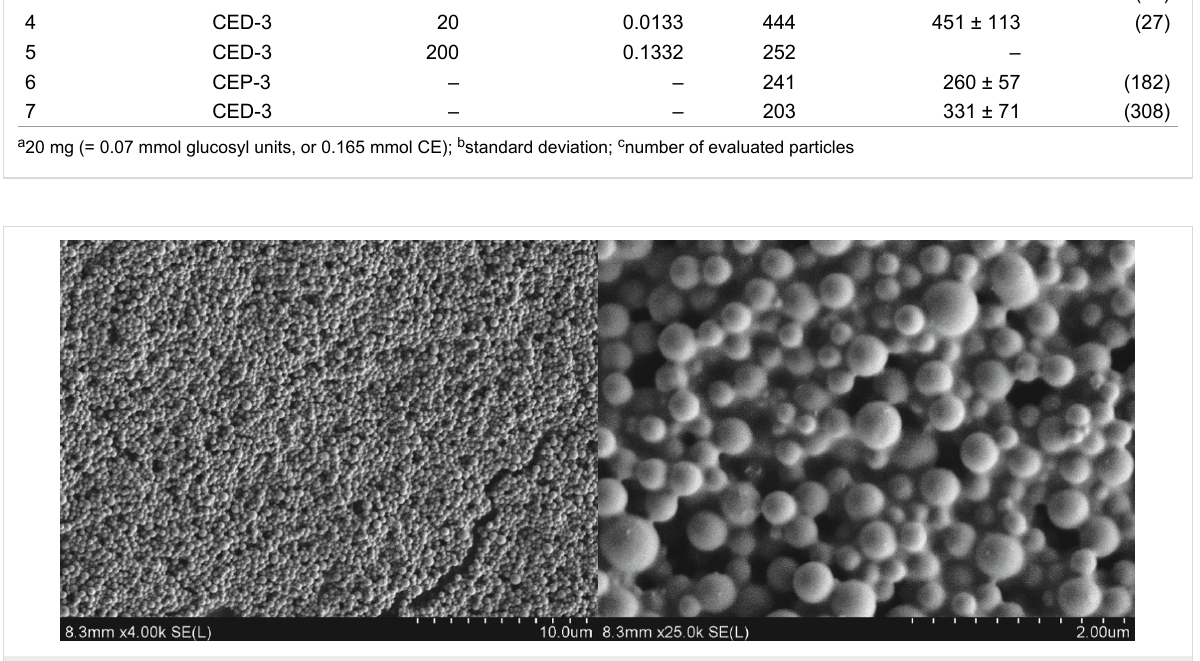
Figure 10: SEM micrographs of CEP-3 with iron oxide nanoparticles, (Table 3, entry 2).